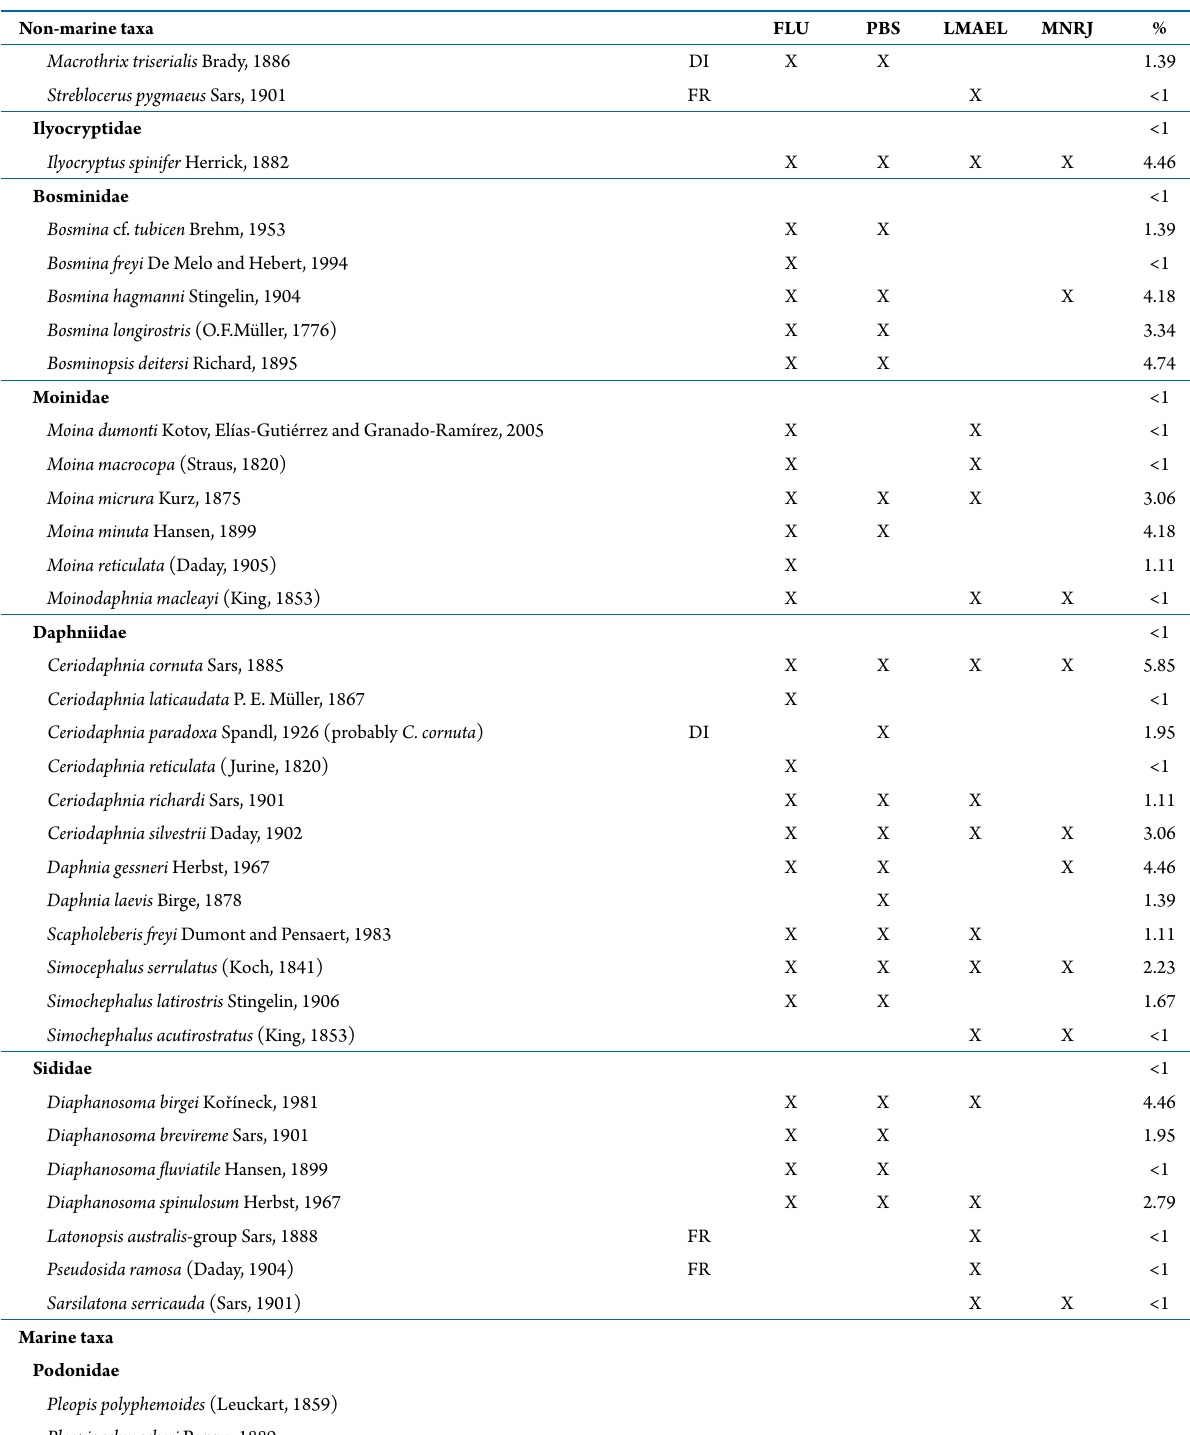
Table 2. Cont. Non-marine